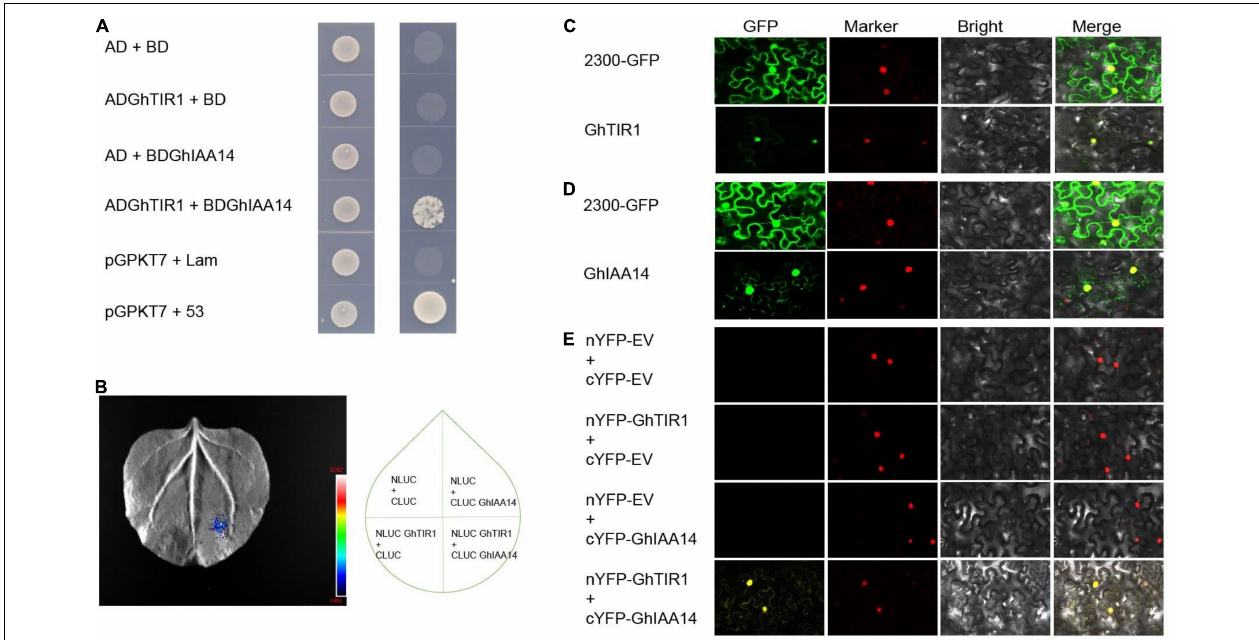
FIGURE 7 | GhTIR1 interacts with GhIAA14 in the cell nucleus. (A) Yeast two-hybrid (Y2H) assay detection of interaction between GhTIR1 and GhIAA14. (B) NLUC-GhTIR1 and CLUC-GhIAA14 show LUC fluorescence. (C,D) Distribution of GhTIR1 and GhIAA14 in the cell. (E) Bimolecular fluorescence complementation (BiFC) assay showing the interaction of GhTIR1 with GhIAA14 in the cell nucleus.